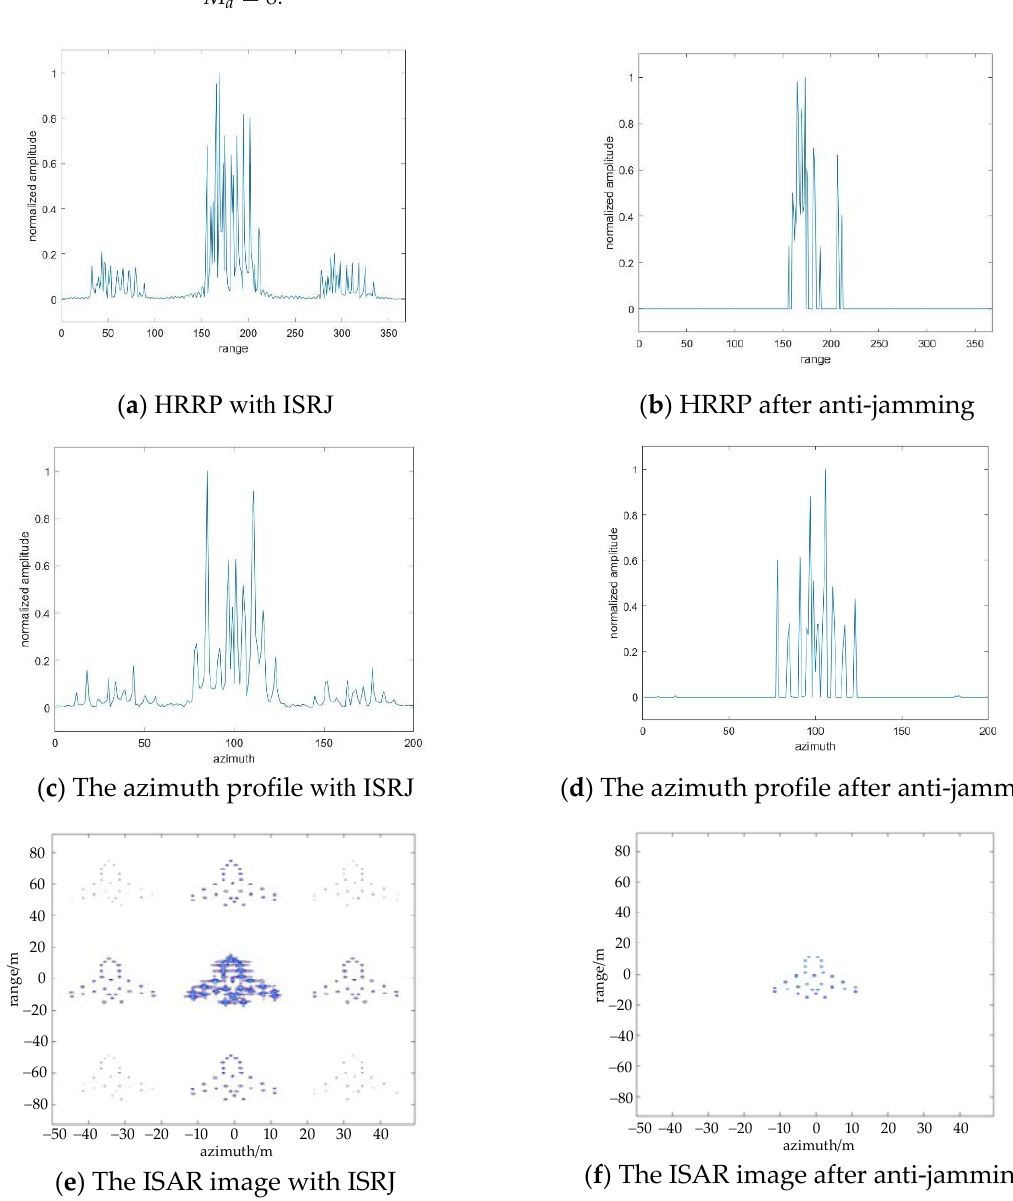
( d ) The ISAR image after anti ‐ jamming Figure 6. The results of ISRJ jamming and anti ‐ jamming in the slow time domain, when Figure 6. The results of ISRJ jamming and anti-jamming in the slow time domain, when M d = 58,   ， M M 58 8 . M a = 8. d a